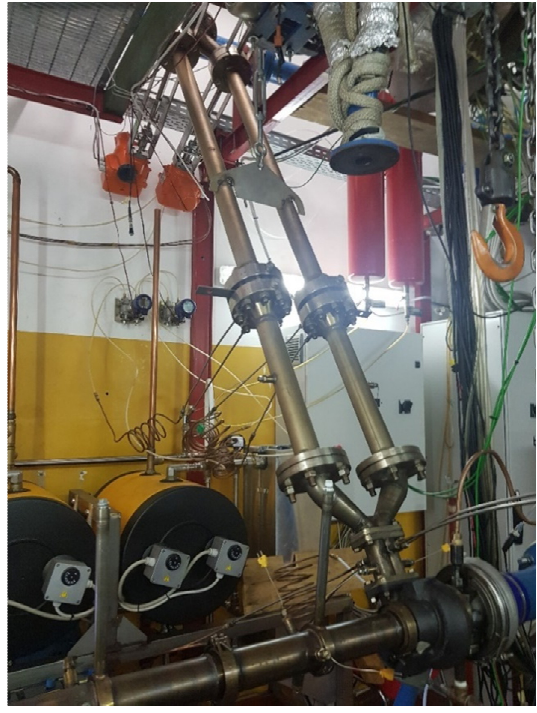
Figure 2. Turbine feeding